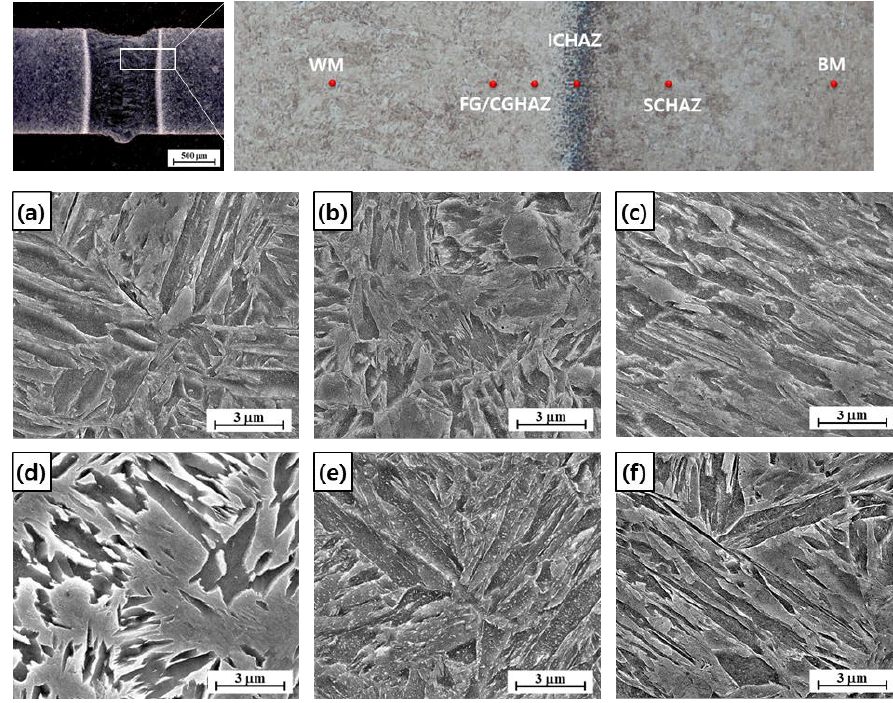
Figure 6. SEM images of bead-on-plate welds (welding speed: 7 m/min): ( a ) weld metal; ( b ) coarse grain heat-affected zone; ( c ) fine grain heat-affected zone; ( d ) intercritical heat-affected zone; ( e ) subcritical heat-affected zone; ( f ) base metal.